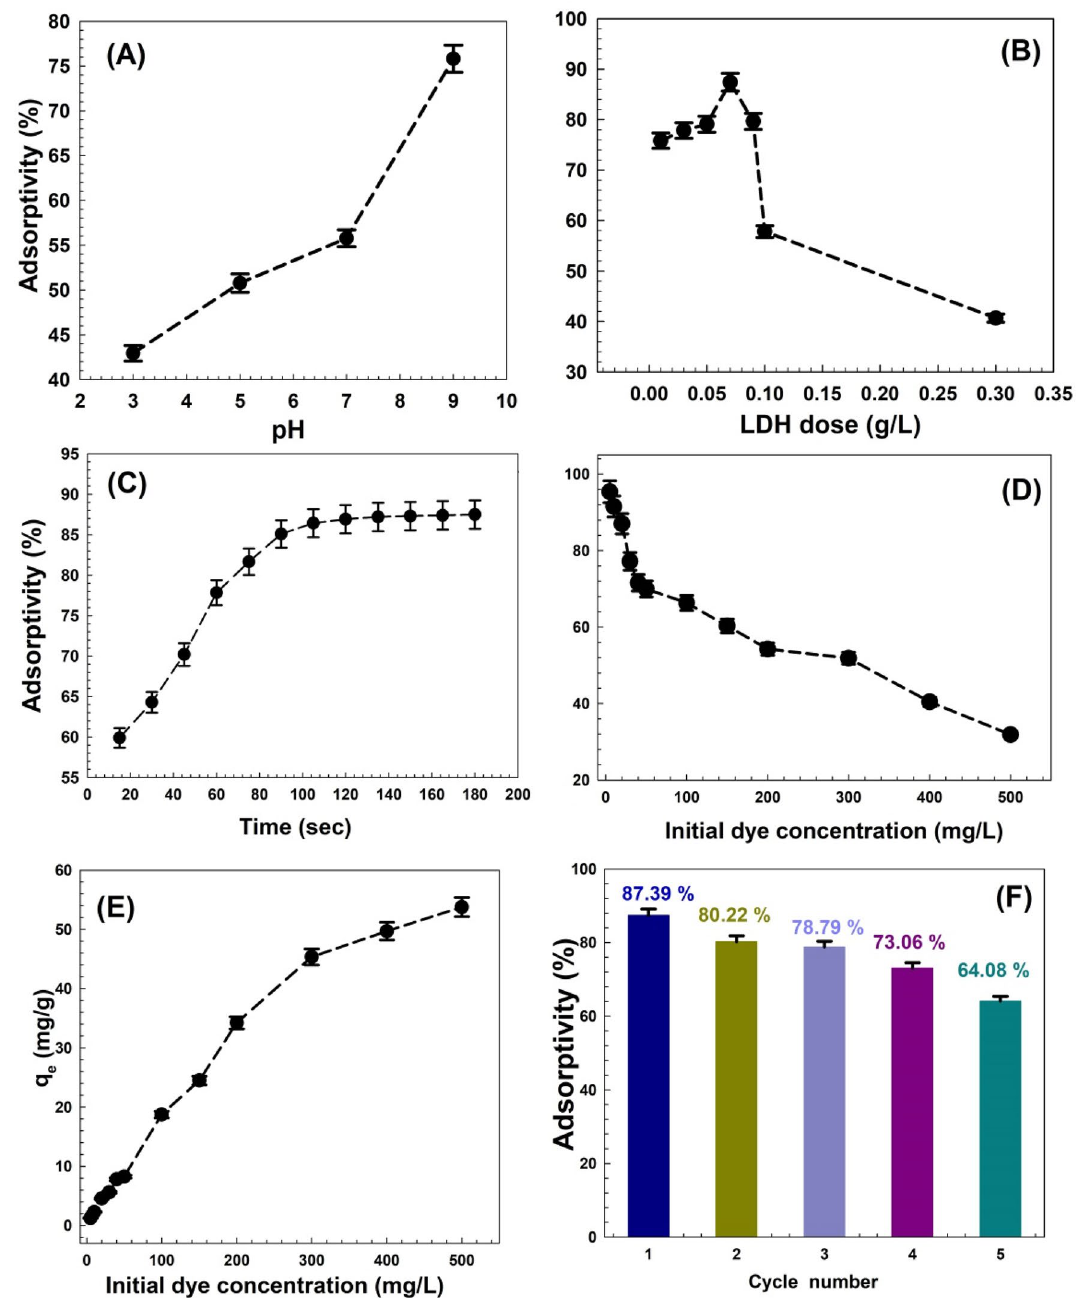
Figure 7. The effect of ( A ) pH solution, ( B ) LDH dose, ( C ) contact time, ( D ) dye concentration, ( E ) initial concentration of CV dye on adsorption capacity, and ( F ) the recyclability of Zn–Mg–Al/LDH on CV adsorption. The smooth short dash curves in the figures are drawn through the data points to guide the